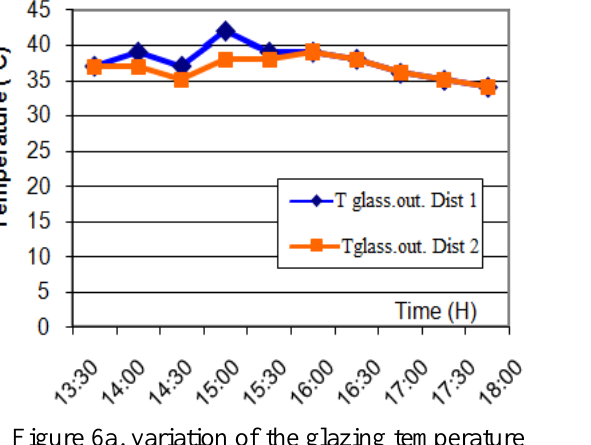
Figure 6b. Variation the interior still temperature